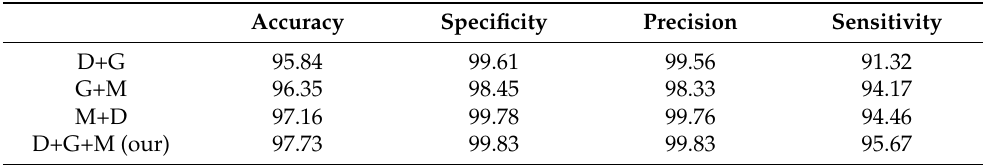
Table 4. Classification results (%) of proposed deep approaches (DenseNet: D, GoogleNet: G, MobileNet: